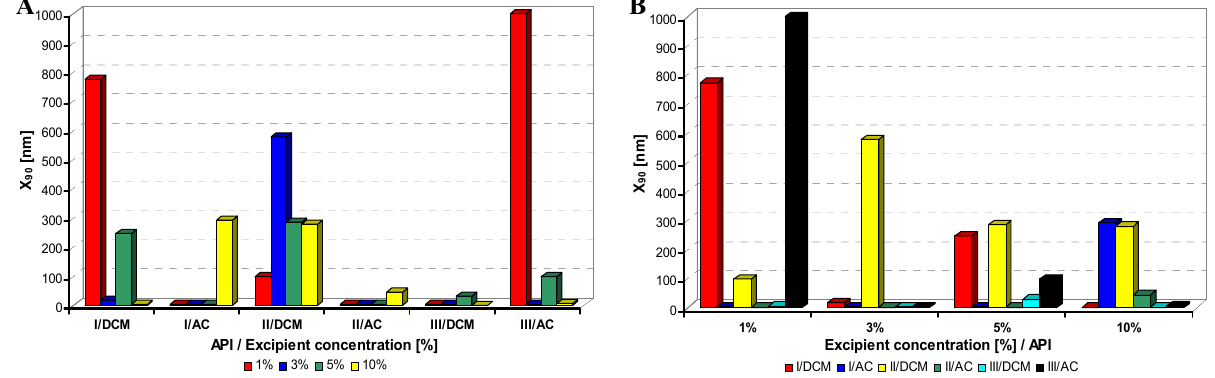
[nm]) of model APIs I – III on concentration [%] Figure 5. Dependence of particle size (x 90 of sodium carboxymethyl cellulose in dichloromethane (DCM) or acetone (AC). ( A ) Samples are grouped according to APIs; ( B ) samples are grouped according to excipient percentage. For clarity sake, the values on y-axis are only to 1,000